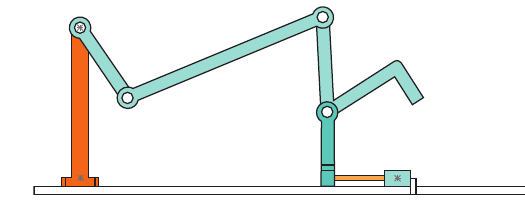
Figure 16: Three-dimensional